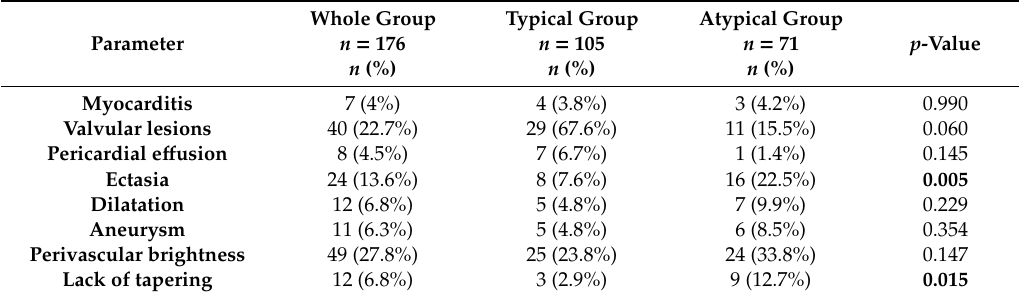
Table 3. Cardiac lesions in the acute phase in typical and atypical KD